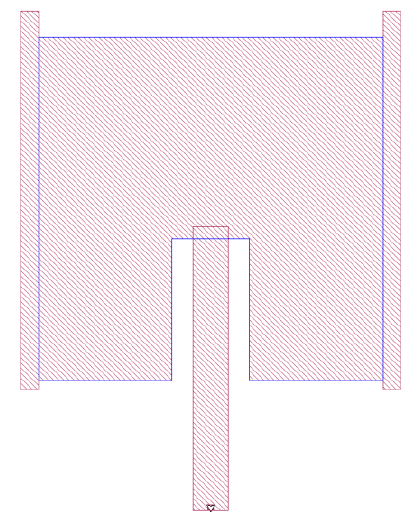
Figure 1. Top view of the antenna